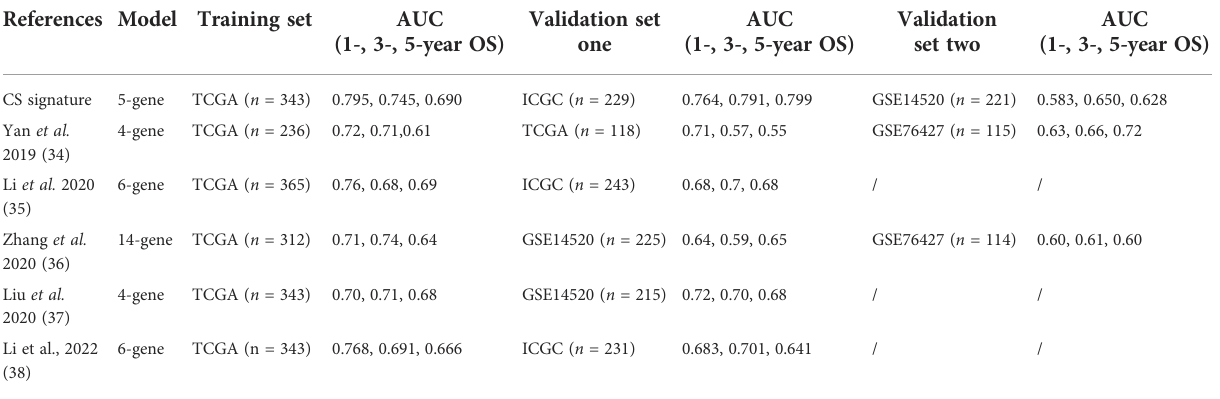
TABLE 2 The comparison with previously reported clinical